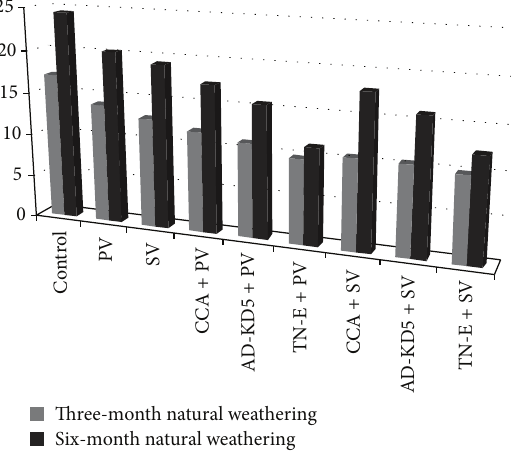
Figure 2: Total color changes ( Δ𝐸 ) of Oriental beech after 3- and 6-month natural weathering. Note: it is drawn by using the average value of Δ𝐸 . See Table 3 for standard